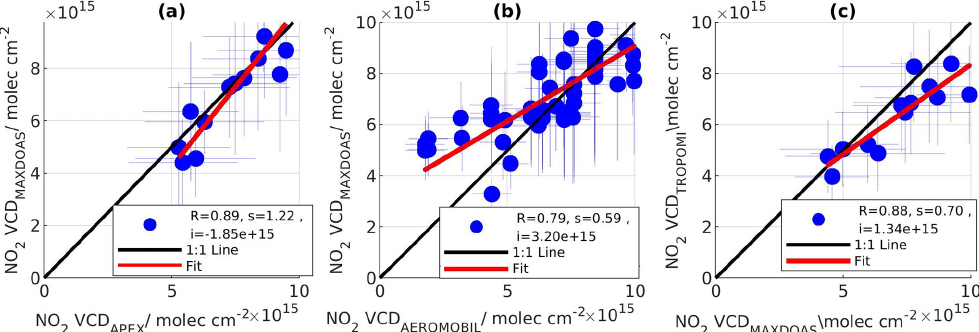
Figure 20. Scatter plot between (a) the tropospheric NO 2 columns derived by airborne measurements (APEX) and the MAX-DOAS obser- vations, (b) the tropospheric NO 2 columns derived by car-mobile DOAS measurements (AEROMOBIL) and the MAX-DOAS observations, and (c) the tropospheric NO 2 columns derived by MAX-DOAS observations and the TROPOMI tropospheric NO 2 columns over Brussels on 28 June 2019.